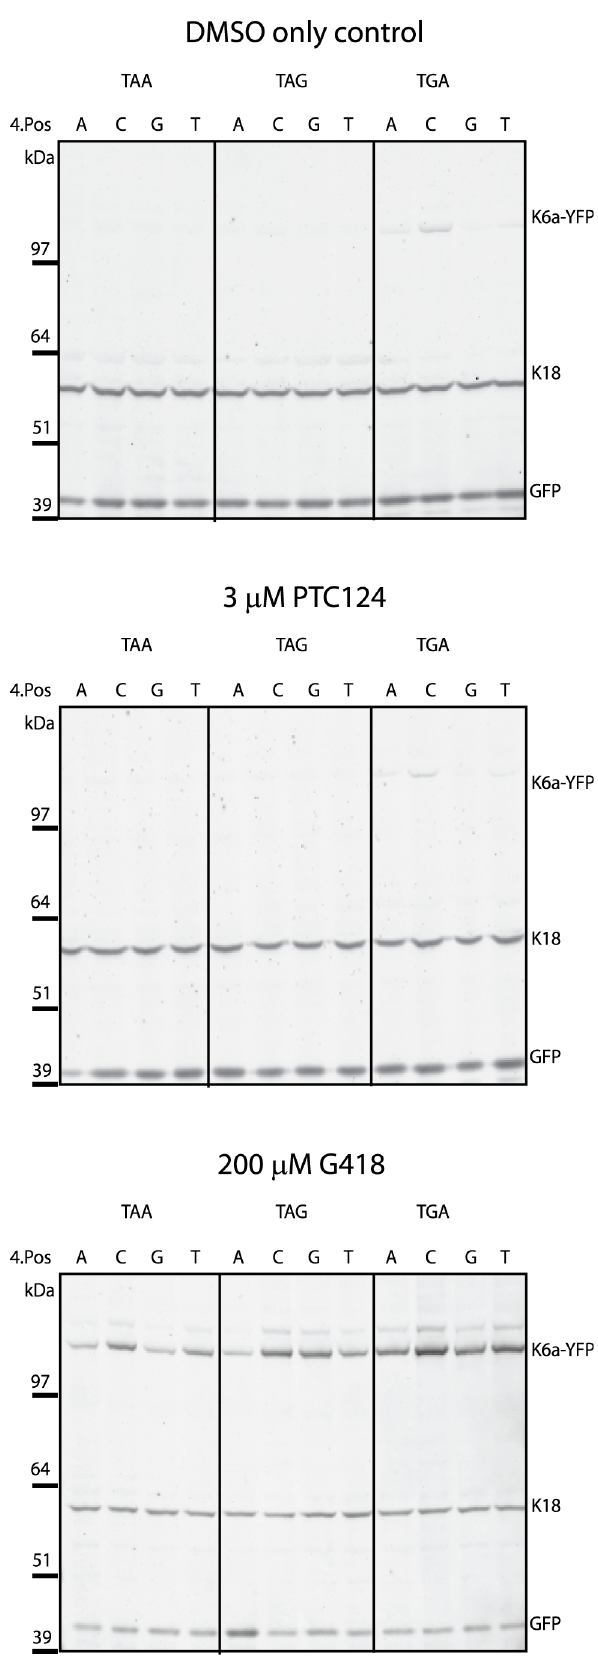
Figure 5. PTC124 does not increase detectable K6a-YFP production for any PTC sequence. Twelve PTC mutant K6a-YFP constructs were generated covering all potential PTC sequence contexts including variations in the + 1 base. All constructs were transiently transfected into AD293 cells, which were subsequently treated with DMSO control, 200 m M G418, or 3 m M PTC124 for 24 hours before Western blots were conducted to determine presence of YFP, GFP transfection control, and K18 loading